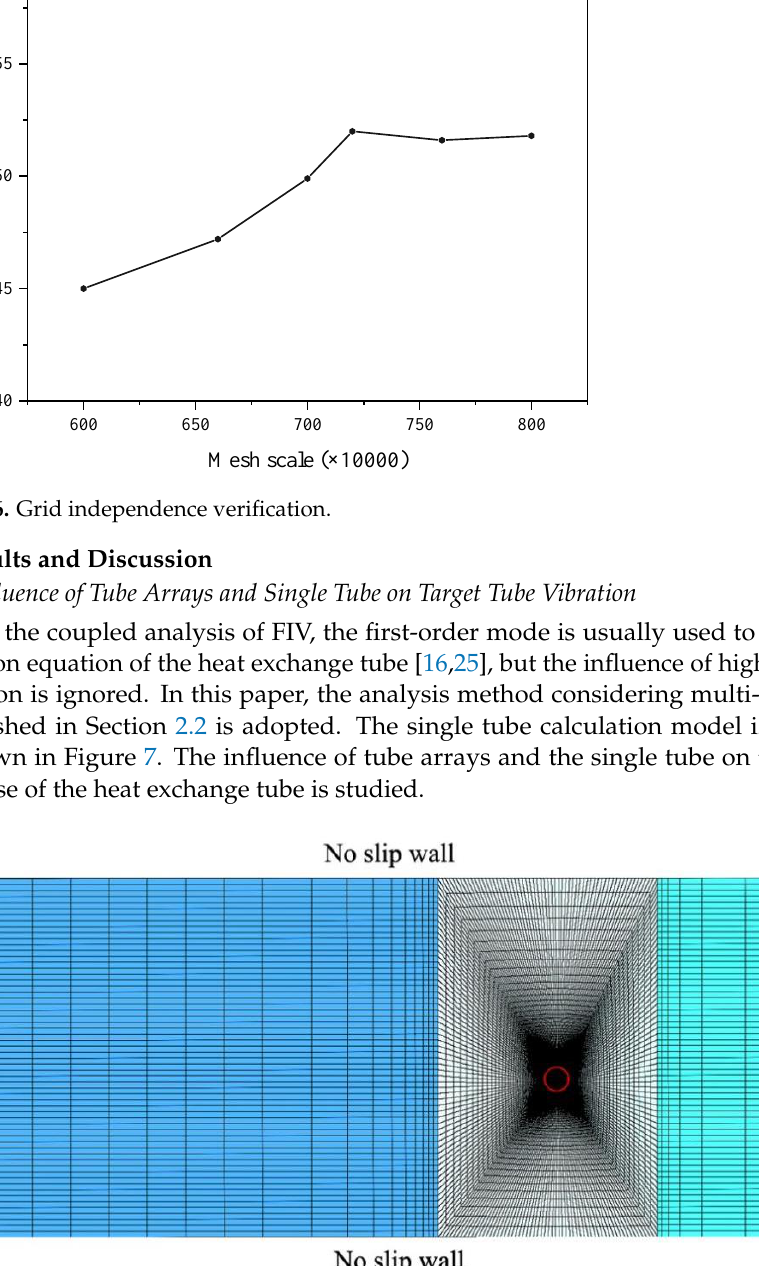
Figure 8. C3 vibration response.